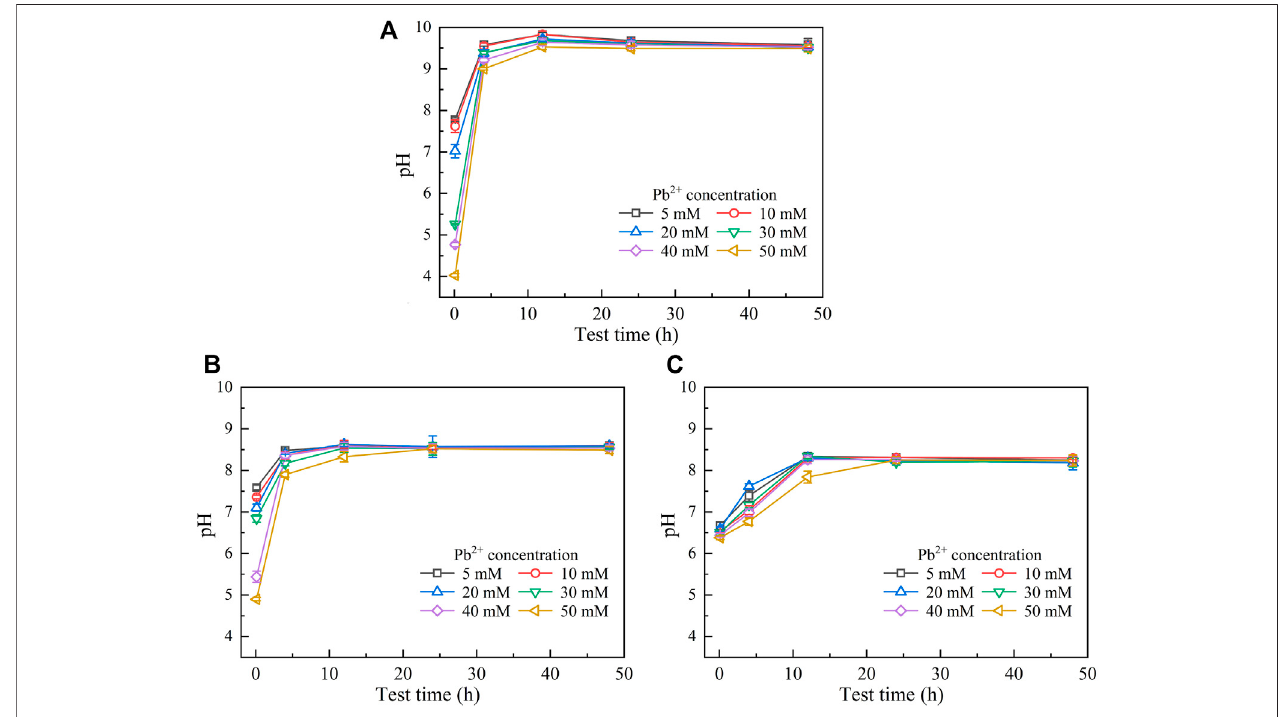
FIGURE 3 | Temporal relationships of urease activity (UA) against Cu(NO 3 ) 2 concentrations: (A) without yeast extract and CaCl 2 , (B) under the effect of yeast extract, and (C) under the effect of yeast extract and CaCl 2